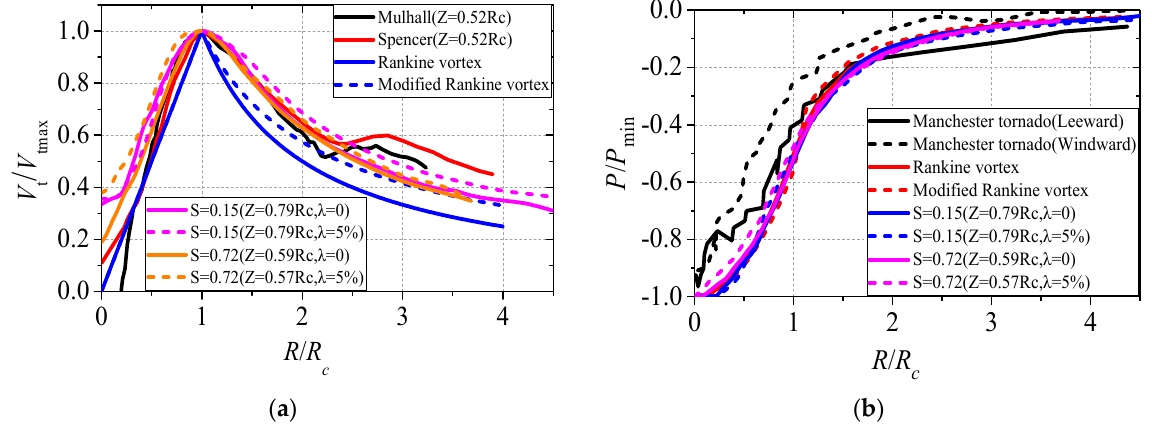
Figure 7. Comparison of normalized radial profiles of tangential velocity ( a ) and pressure drop ( b ) between experimental results, results from empirical models, and data measured from an actual tornado.